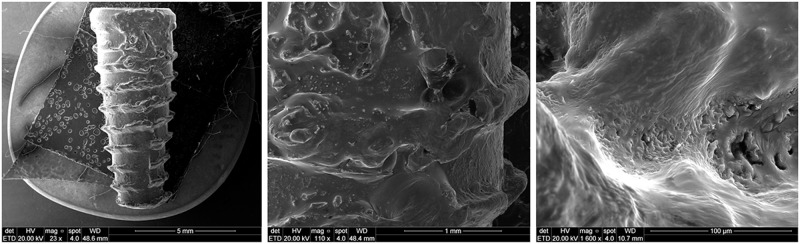
In (a) an image of low magnification of the implant showing great quantity of bone tissue deposition over the entire surface. In (b) an image with more increase showing the presence of bone tissue deposited on the implant surface with a thick layer. In (c) an image with great increase showing that the bone tissue deposition.